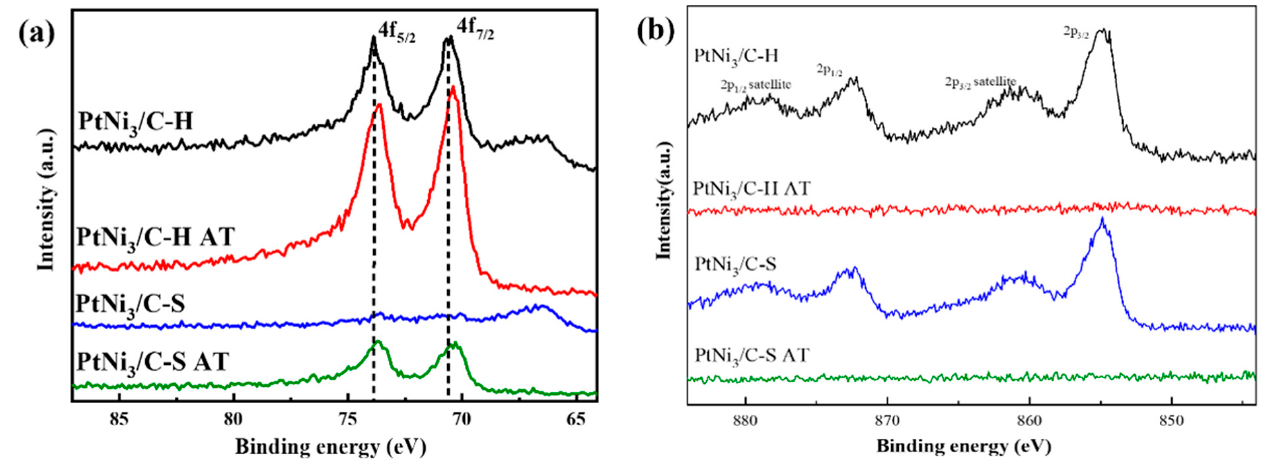
Figure 2. ( a ) Pt 4f and ( b ) Ni 2p XPS spectra of catalysts.